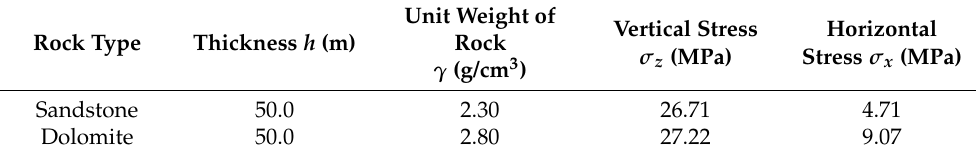
Table 5. Primary